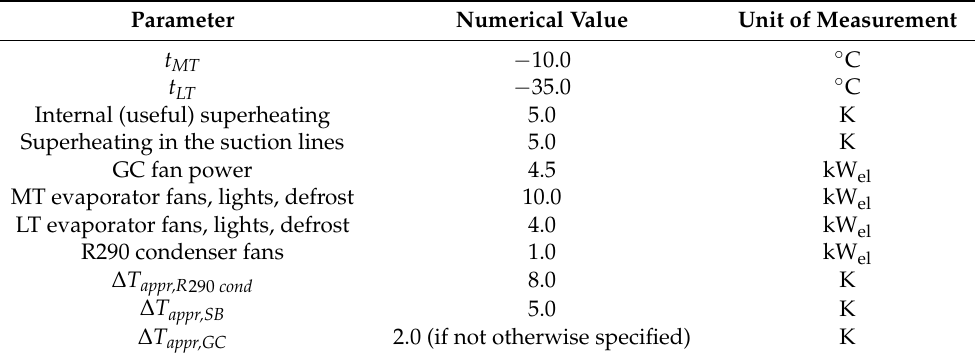
Table 4. Further assumptions needed for the conventional exergy analysis [8]. Parameter